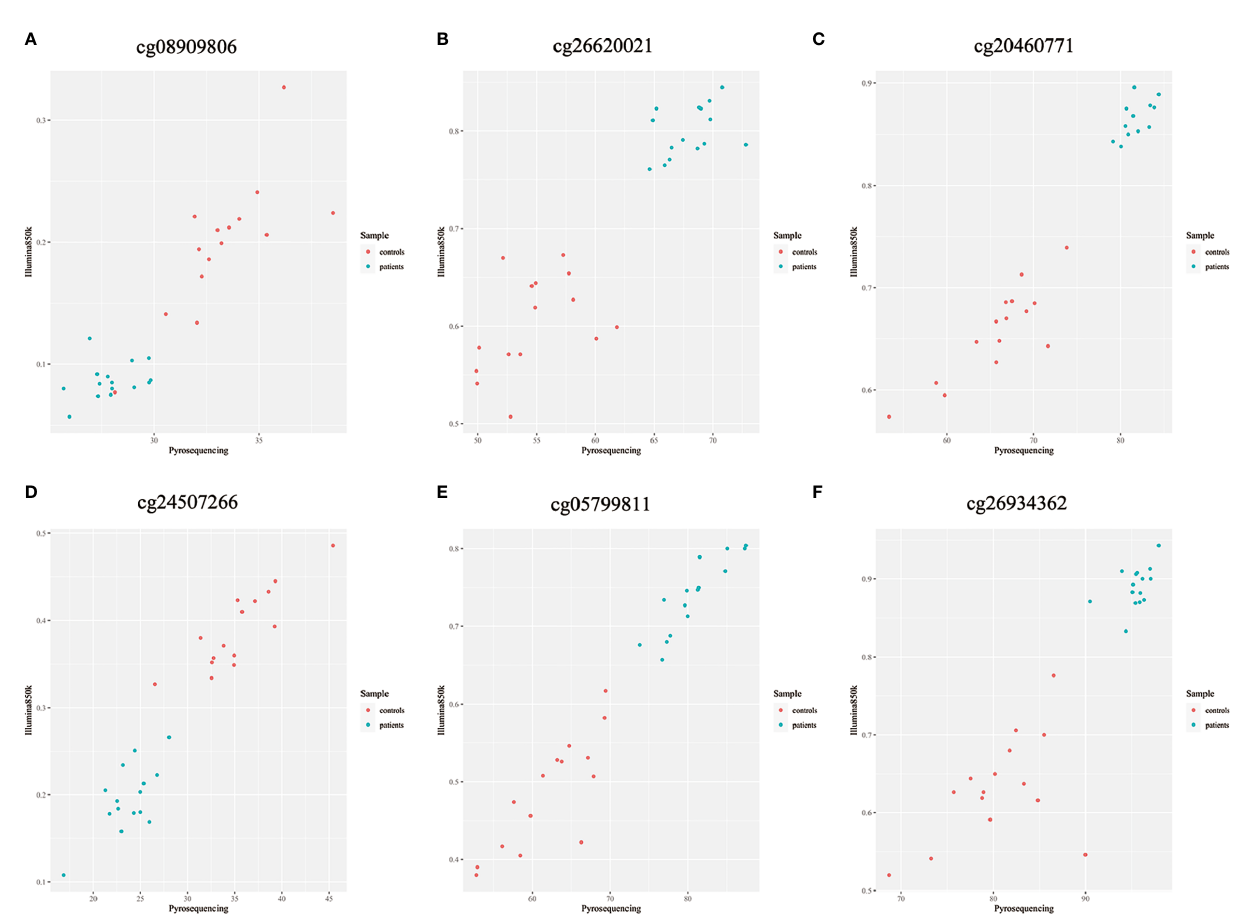
FIGURE 6 | (A – F) Methylation chip and pyrosequencing correlation scatter plot Shown are degrees of methylation in 6 CpG loci (cg08909806, cg26620021, cg20460771, cg24507266, cg05799811, cg26934362) reported by Illumina In fi nium Human Methylation 850k BeadChip (Y axis, ratio) and pyrosequencing (X axis, percentage) assays. Blue and red dots in each panel plot values of methylation at a given site among individual patients with ICH (n=15) and controls